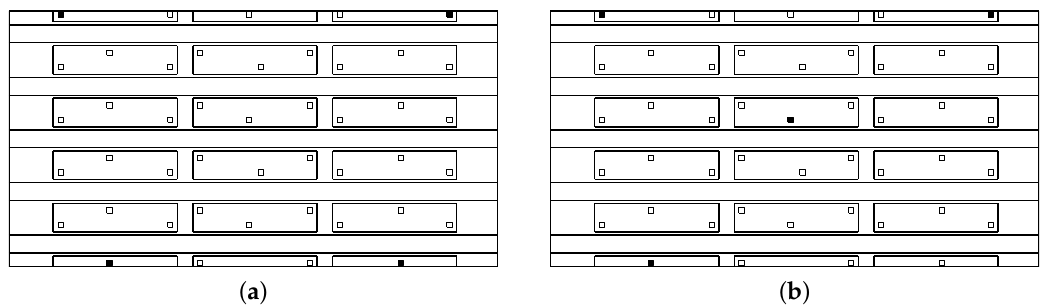
Figure 9. Best four-sensor combination. Uniform probability ( a ); non-uniform probability ( b ). Table 4. Comparison of network performance for uniform prior probability (Performance upp ) and variable prior probability (Performance vpp